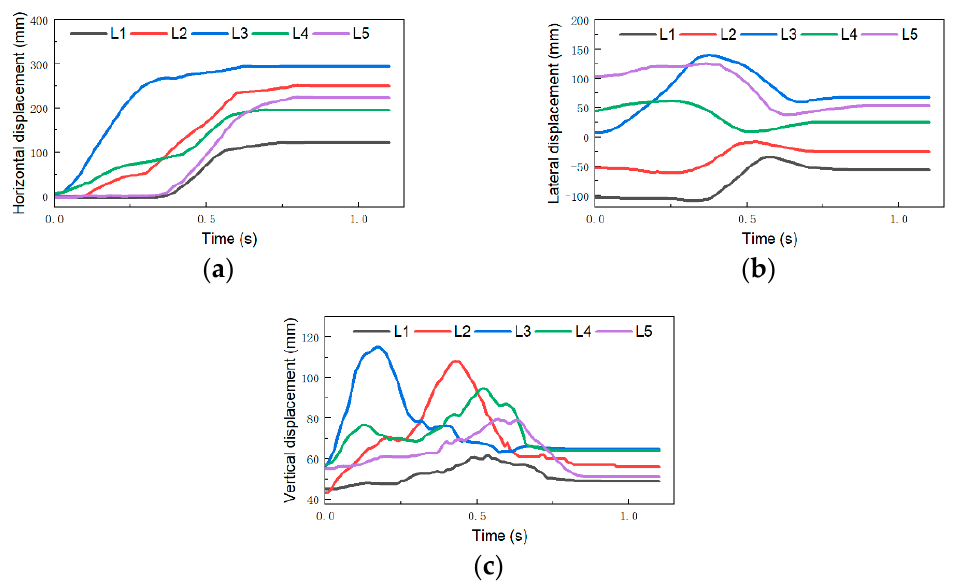
Figure 12. The motion curves of soil particles at different locations during tillage: ( a ) movement curve of soil particles along the x ‐ direction; ( b ) movement curve of soil particles along the y ‐ direction; ( c ) Movement curve of soil particles along the x ‐ direction.